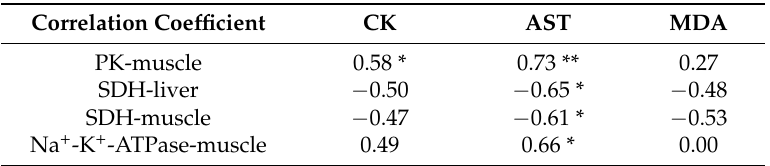
Table 2. Correlation analyses between biochemical parameters (creatinine kinase (CK), aspartate transaminase (AST), and malondialdehyde (MDA)) and energy metabolic enzymes. PK—pyruvate kinase; SDH—succinate